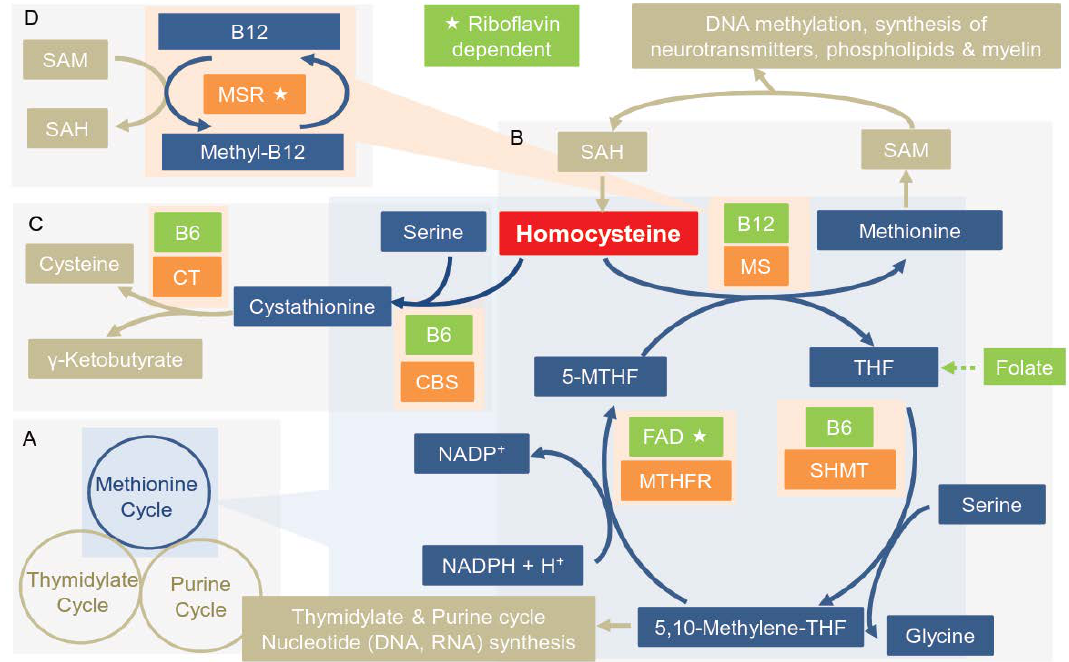
Figure 1. Metabolic pathways of the one-carbon metabolism: ( A ) Overview of the three cycles; ( B ) Methionine cycle: remethylation of homocysteine to methionine; ( C ) Transsulfuartion pathway: